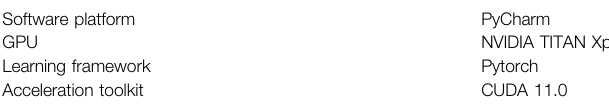
TABLE 1 | Experiment con fi guration.